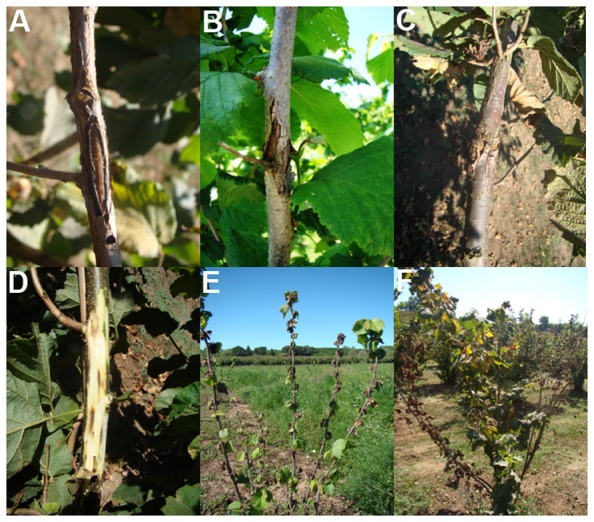
Characteristic symptoms of bacterial blight observed on woody parts across the hazelnut field during late summer.Canker symptoms and cracking of bark tissues, caused by Xatnthomonas arboricola pv. corylina, on the twigs and branches of hazelnut observed in the field (A, B and C), browning of the sub-cortical tissues (D), wilting of shoots (E) and dieback of branches (F). Figures E and F report the symptoms caused by Xac, rarely found in the field and very similar to those caused by Pseudomonas syringae pv. avellanae.